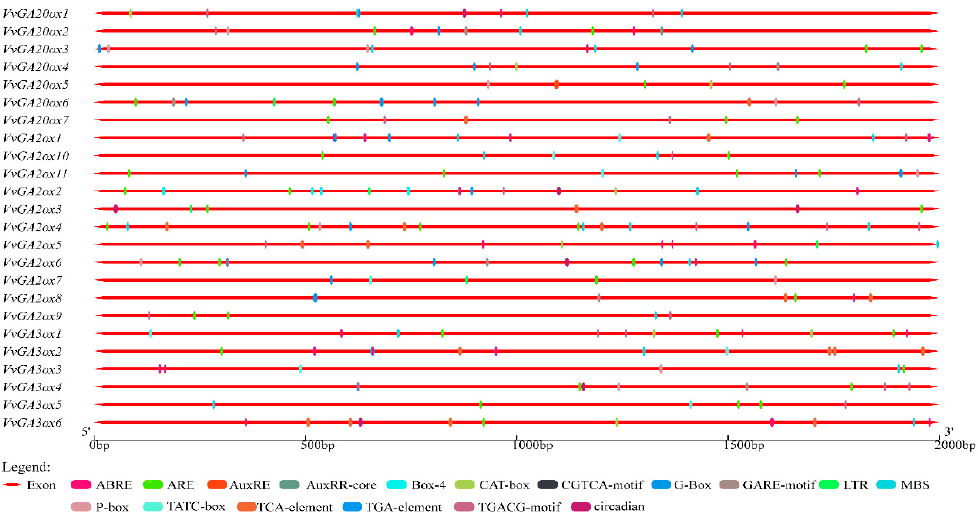
Figure 7. Number of cis-acting elements in GA2ox, GA3ox and GA20ox promoter of grape. Note : ABRE, abscisic acid responsiveness. ARE, regulatory element essential for the anaerobic induction. AuxRE, auxin-responsive element. AuxRR-core, regulatory element involved in auxin responsiveness. Box-4, part of a conserved DNA module involved in light responsiveness. CAT-box, cis-acting regulatory element related to meristem expression. CGTCA-Motif, cis-acting regulatory element involved in the MeJA-responsiveness. G-Box, cis-acting regulatory element involved in light responsiveness. GARE-Motif, gibberellin-responsive element. LTR, cis-acting element involved in low-temperature responsiveness.MBS, MYB binding site involved in drought-inducibility. P-box, gibberellin-responsive element. TATC-box, cis-acting element involved in gibberellin-responsiveness. TCA-element, cis-acting element involved in salicylic acid responsiveness. TGA-element, auxin-responsive element. TGACG-Motif, cis-acting regulatory